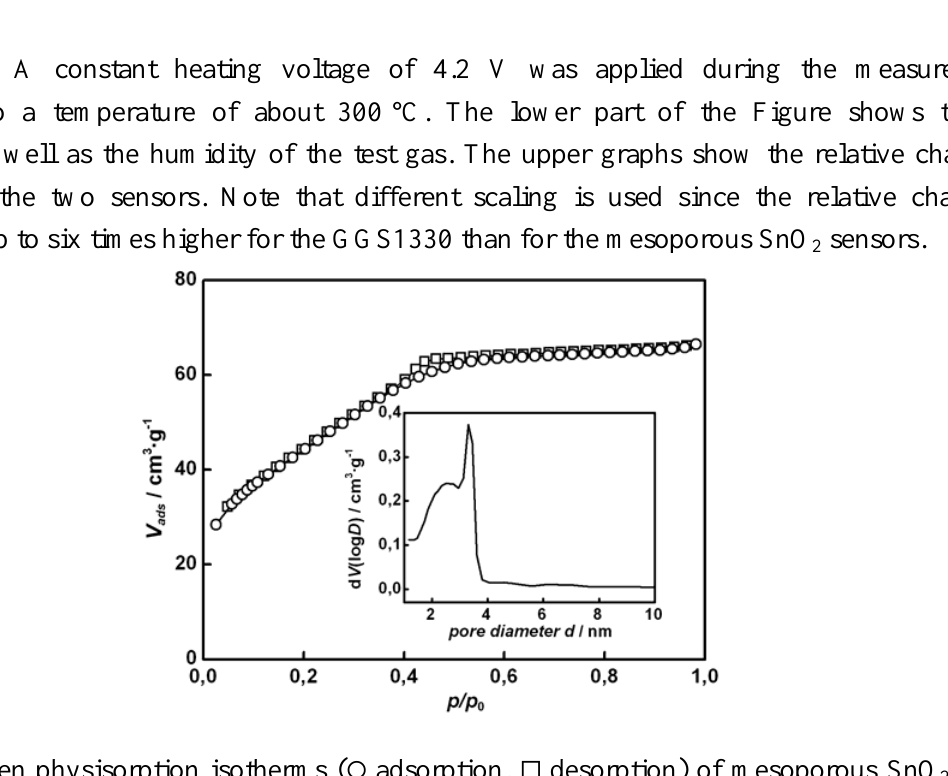
Figure 3. Nitrogen physisorption isotherms ( (cid:123) adsorption, (cid:133) desorption) of mesoporous SnO BJH pore size distribution.